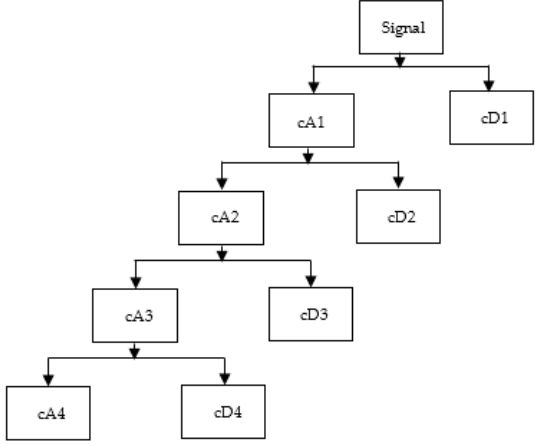
Figure 5. Schematic diagram for decomposition of vibration signal.